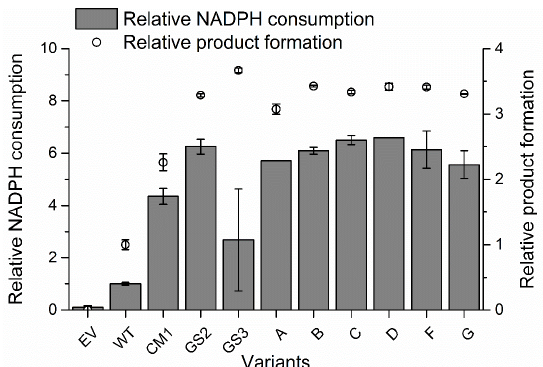
Figure A6. Agarose gel (1% ( w / v )) confirmation of epPCR products. Amplifications using in-house Taq DNA polymerase, 1- MWM 1 kb GeneRuler, 2 to 12–0.05 mM heme domain (1452 bp).